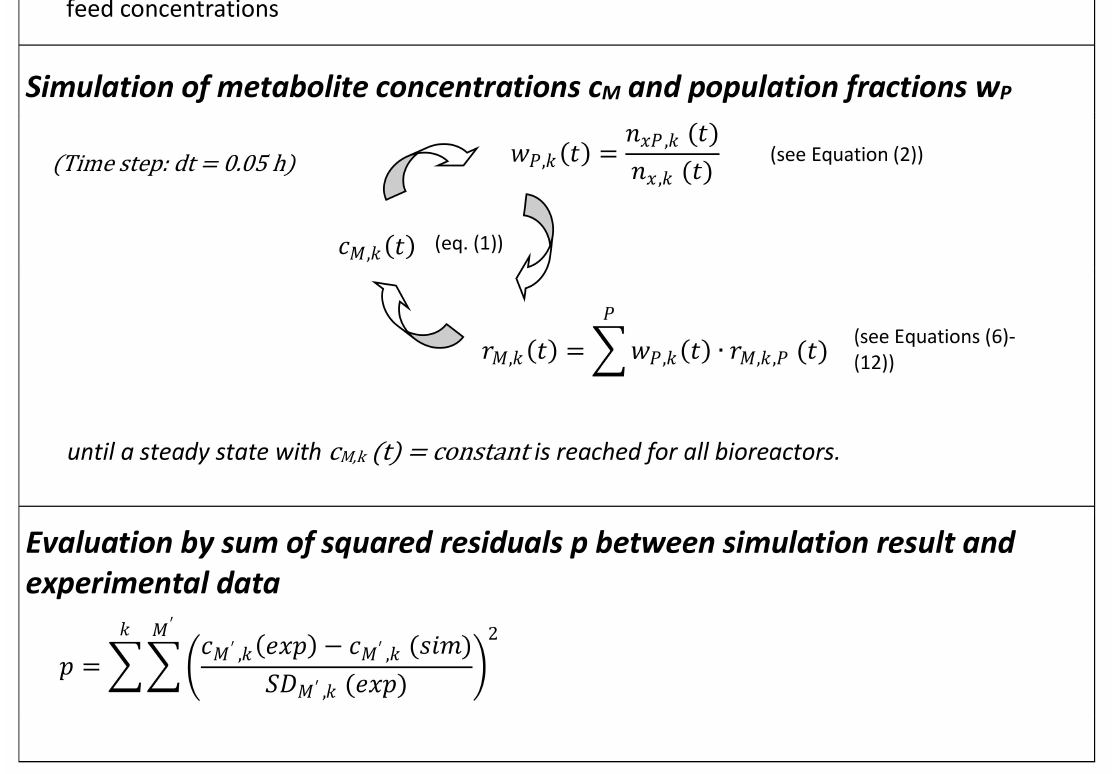
Figure 2. Schematic representation of the mathematical modeling approach. Metabolites M = {x; glu; aa; ba; eth; act; but; PO4}; measured metabolites M’ = {x; glu; aa; ba; eth; act; but}; bioreactor stages k = {1; 2; 3; 4; 5; 6}; biomass subpopulations P = {A; I;